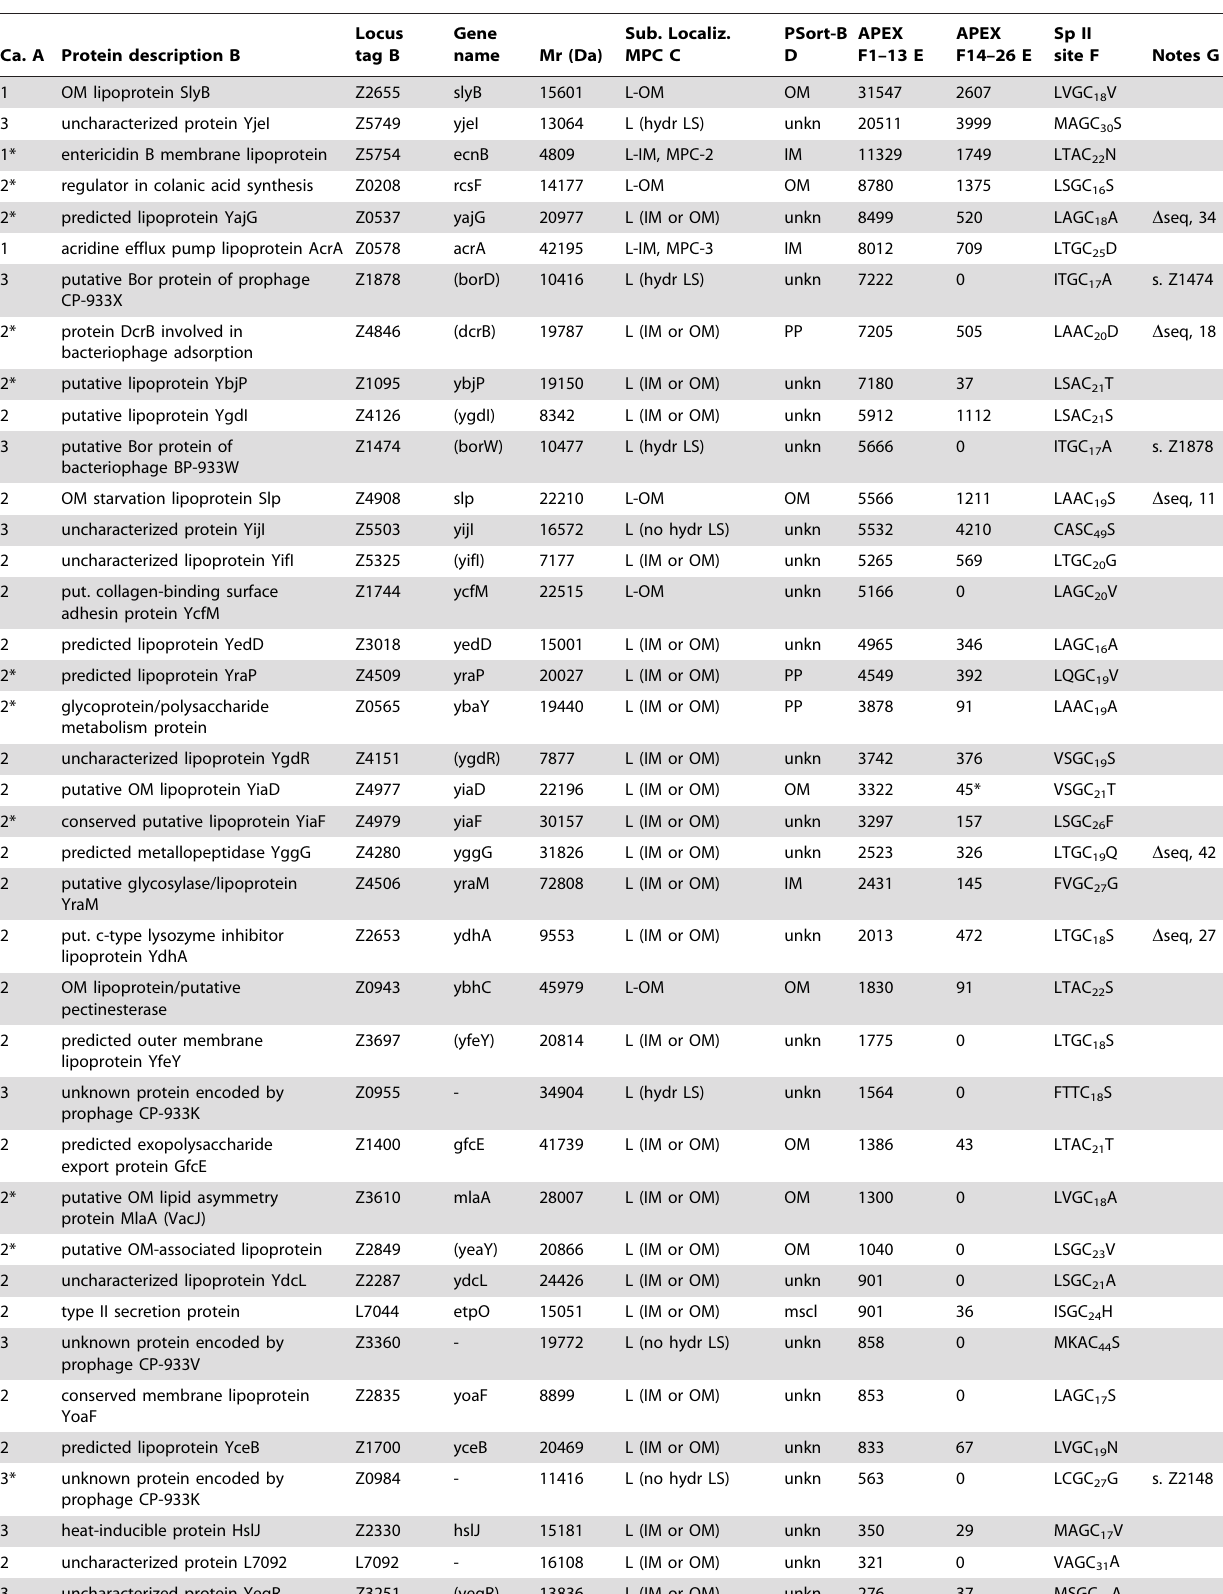
Table 1. Putative EHEC lipoproteins markedly enriched in size exclusion chromatography fraction F1-s SEC